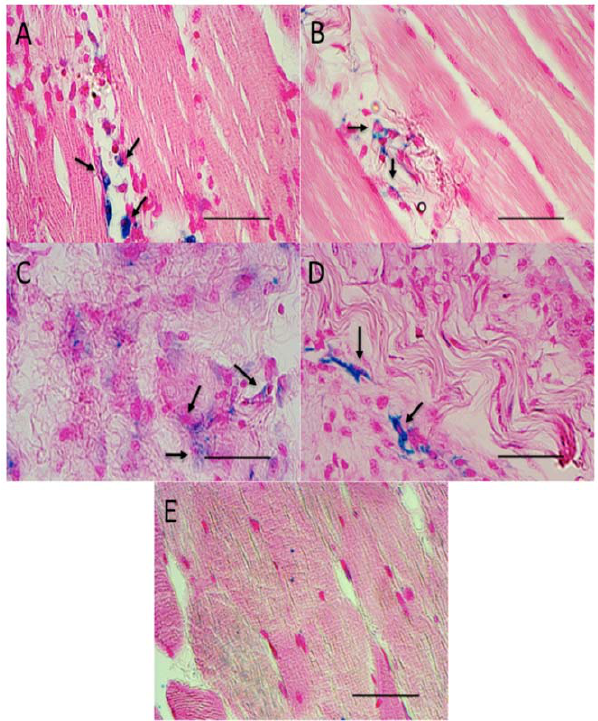
Figure 4. Prussian blue staining of FL-SPION-labeled macro- phages in muscle tissue following FUS exposures. Muscle following pFUS on days 3 ( A ) and 8 ( B ) post-treatment. pFUS-treated tissue shows well preserved cytoarchitecture with increased gaps between muscle fiber bundles and infiltration of macrophages (arrows). Tissue exposed to cFUS is shown 3 ( C ) and 8 ( D ) days after. Large amounts of necrosis and macrophage infiltration are seen with no discernable histological integrity through the treatment volume. Control untreated muscle is shown in (E). Scale bars represent 50 m m.